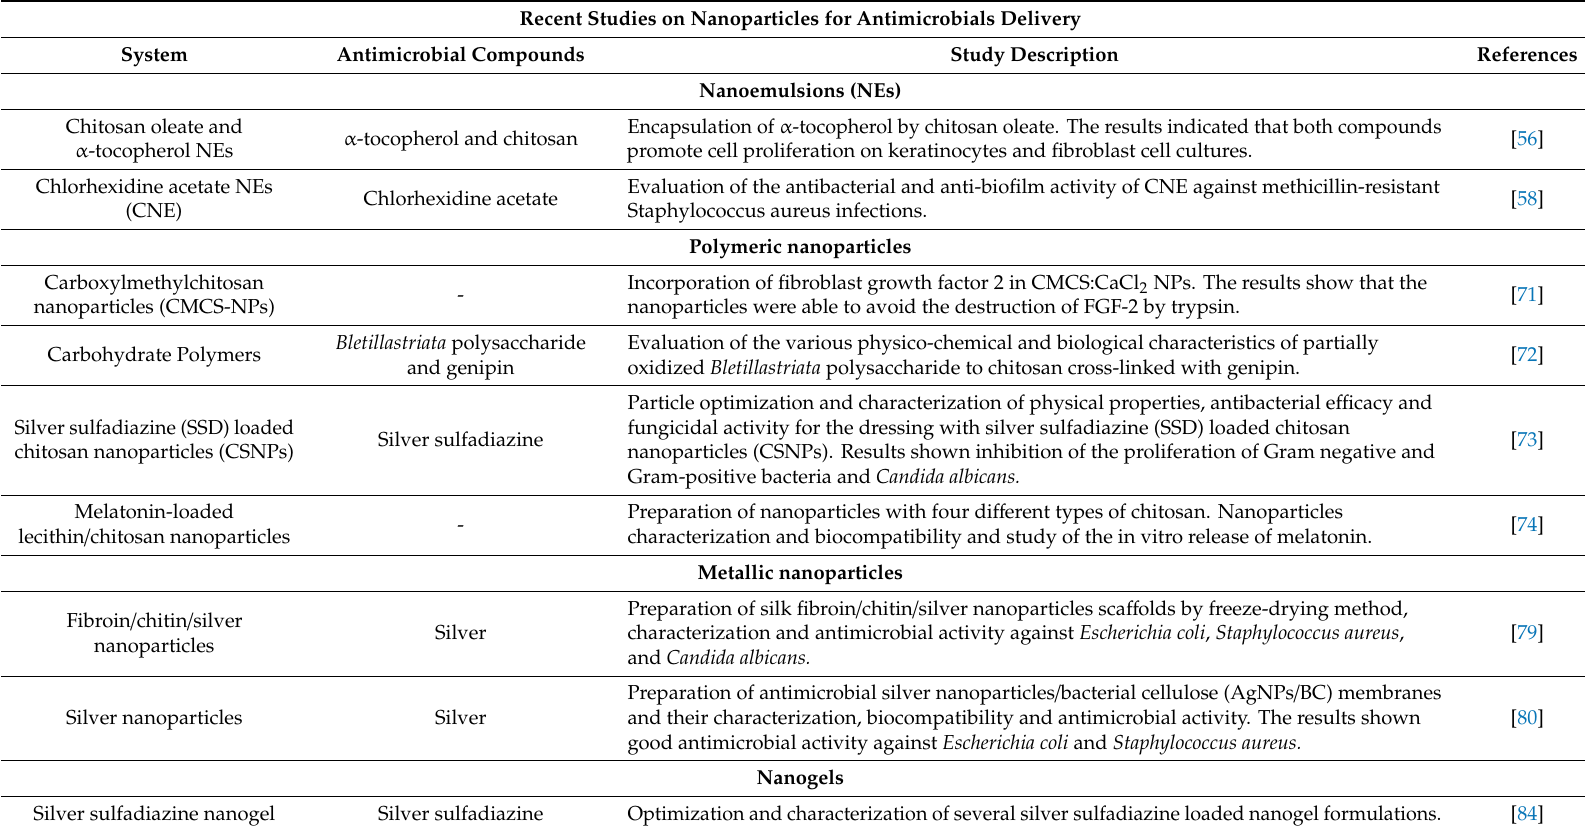
Table 2. Summary of the recent studies on nanosystems, wound dressings and tissue engineering for burn wound